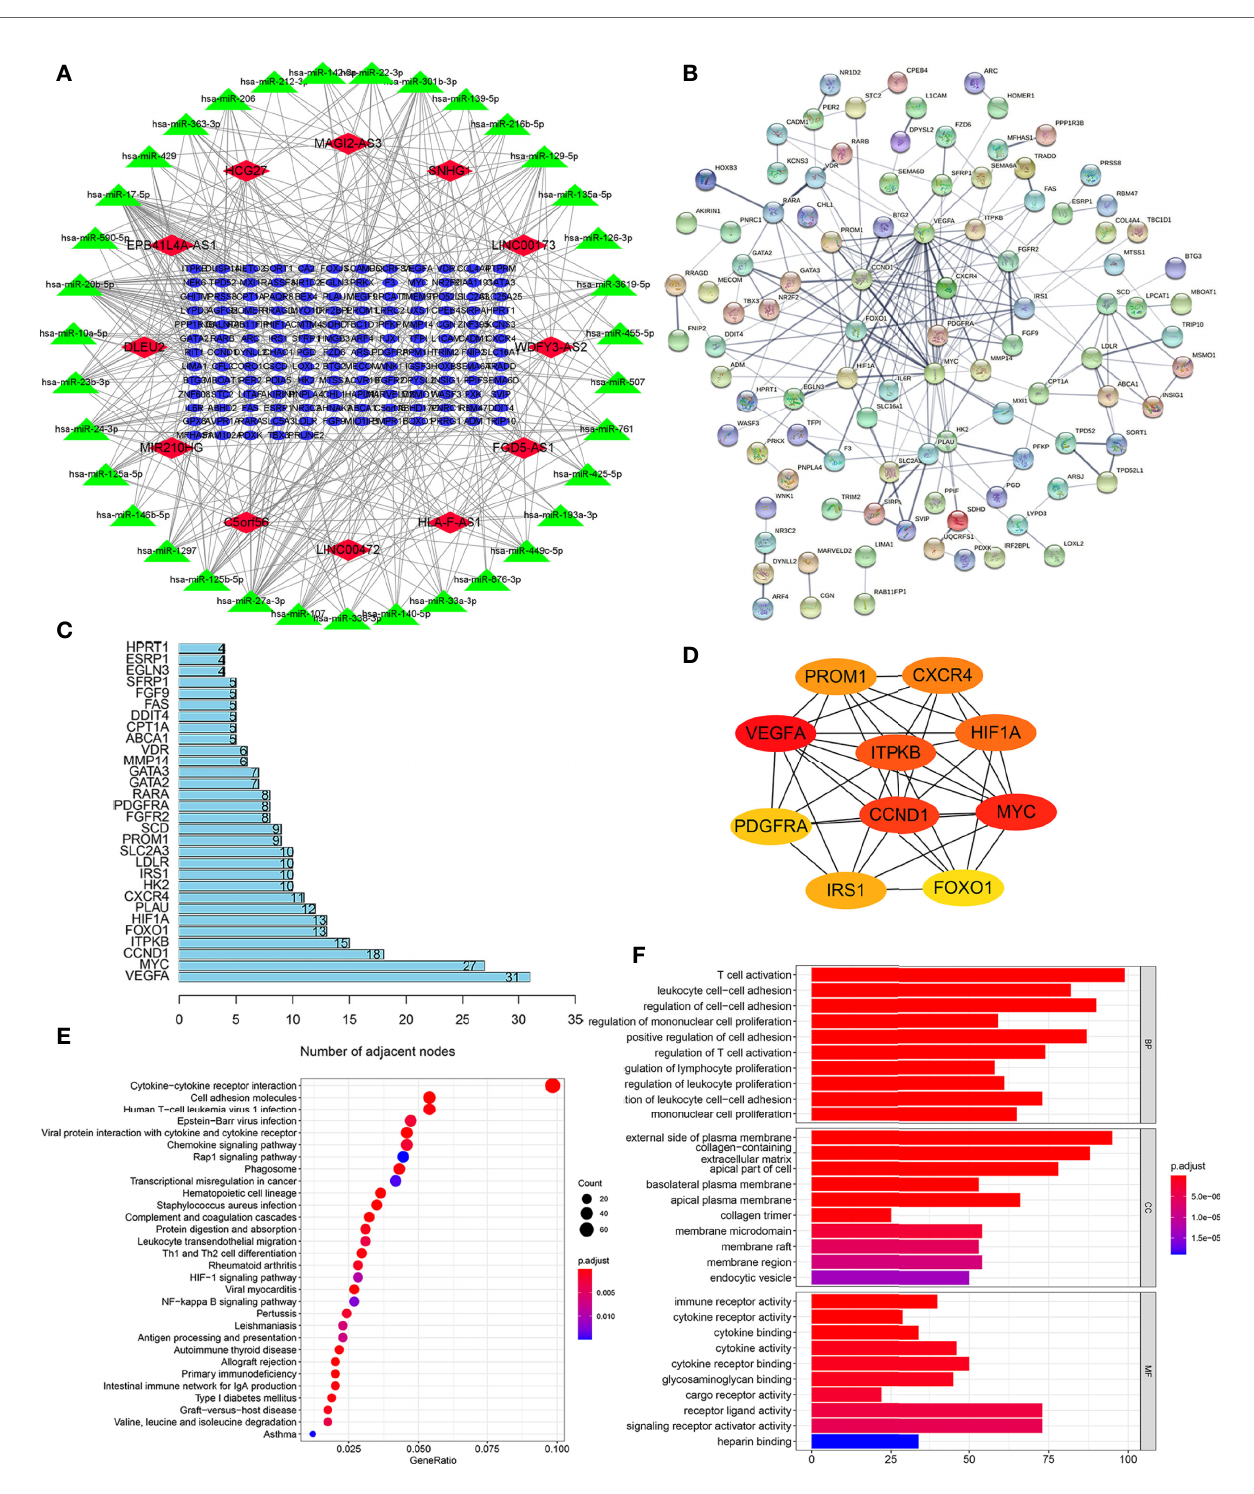
FIGURE 8 | Construction of a lncRNA-miRNA-mRNA ceRNA network and protein-protein interaction (PPI) network, as well as functional enrichment analysis. (A) The ceRNA network displayed 12 m6A-related lncRNAs and their sponged miRNAs and targeted mRNAs. (B) PPI network of target genes. (C) The bar chart showed the number of connecting nodes of target mRNAs in PPI network. (D) PPI network of the top 10 hub genes obtained from CytoHubba plugin of Cytoscape. (E) Bubble diagram of Kyoto Encyclopedia of Genes and Genomes (KEGG) pathway analysis revealed the enriched signaling pathways of targeted mRNAs. (F) Gene Ontology (GO) analysis of targeted mRNAs revealed the enriched biological processes, cell components, and molecular